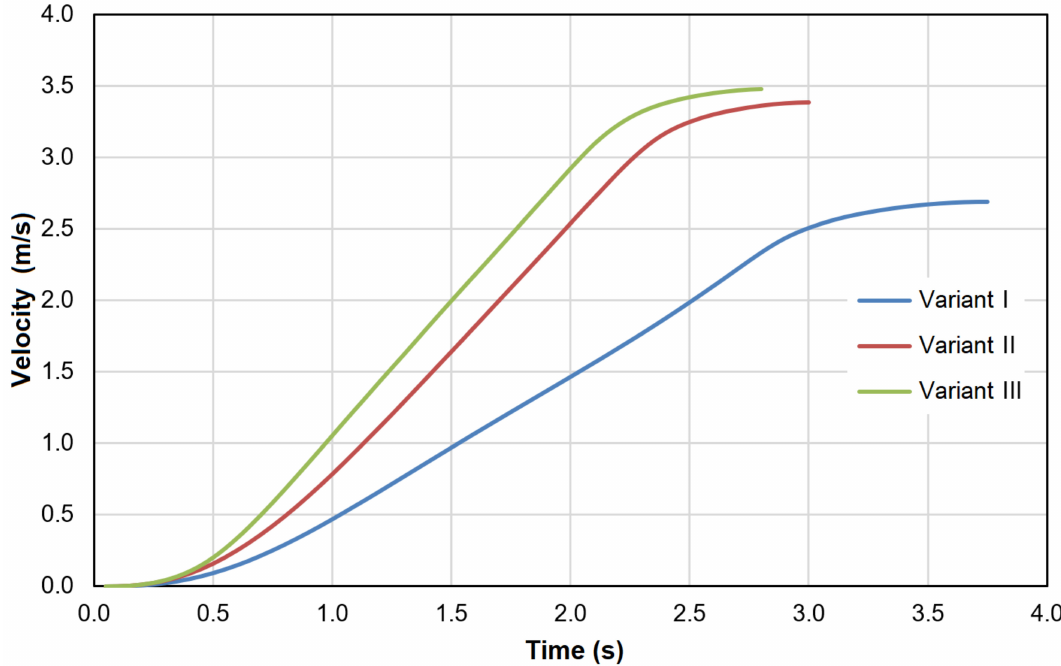
Figure 19. Hammer velocity vs. time for three variants of the calculation